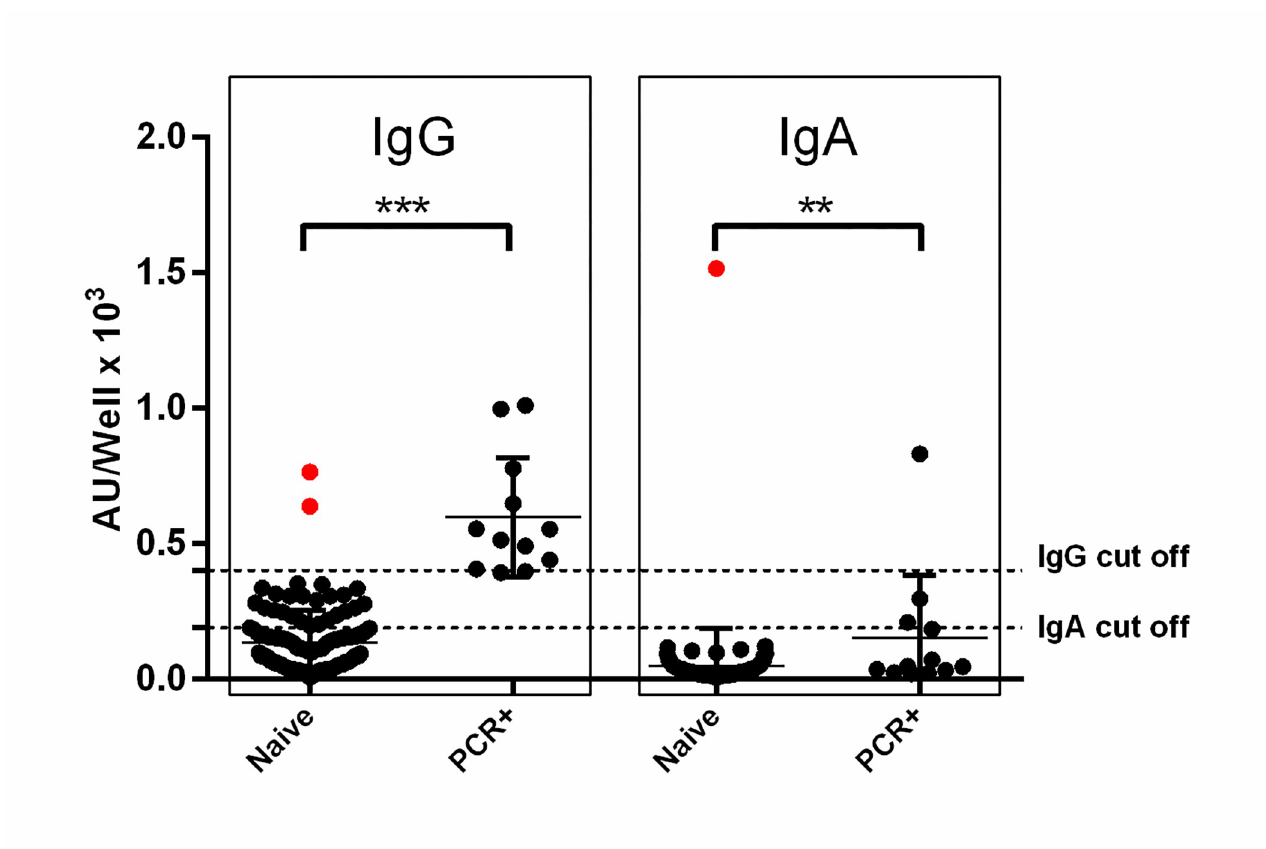
Fig 2. Serum anti-N IgG and IgA antibody levels prior to vaccination. For PCR- Na ï ve individuals (n = 134) and PCR+ (n = 12) individuals the sample prior to vaccination was on Day0. The cut-off point of IgG and IgA ELISAs was established at 400 AU/well and 170 AU/well, respectively (dashed lines). Asterisks ( � ) indicate statistically significant differences ( p -value: �� < 0.01, ��� < 0.001) between the compared groups. Each dot represents an individual and error bars represent the mean value and standard deviation of the distribution.